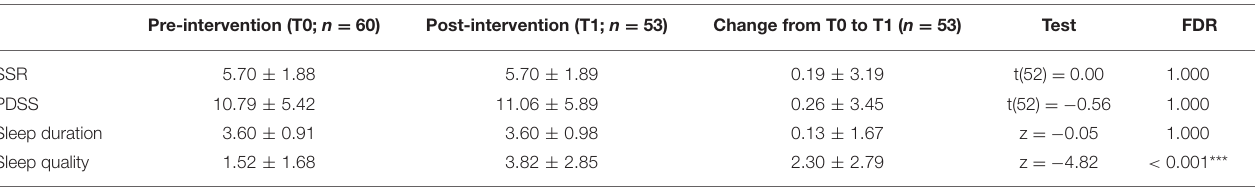
TABLE 4 | Comparison between pre- and